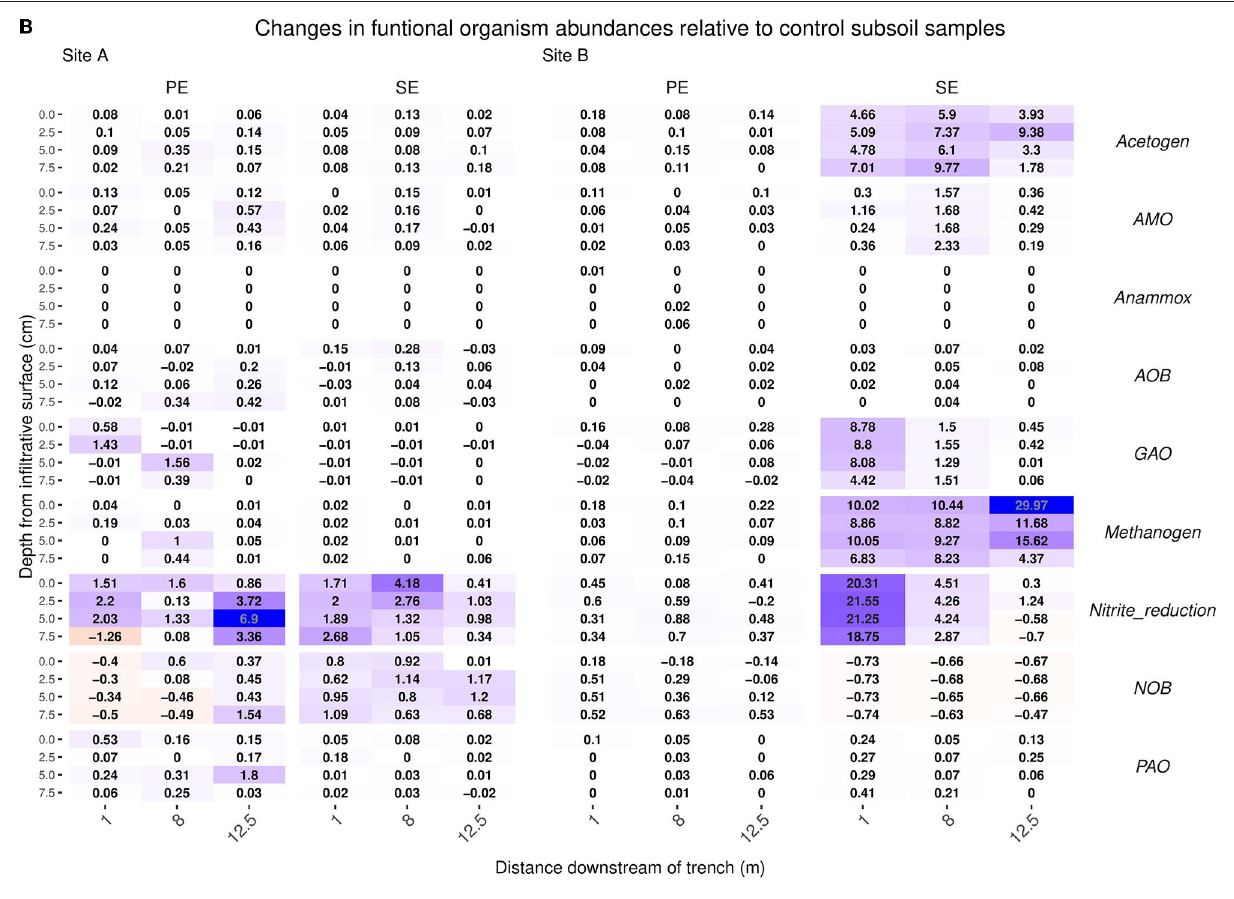
FIGURE 7 | (A) Mean ± SD of relative read abundance of Anaerobic Methane Oxidizers (AMO), Denitrifying bacteria, polyphosphate-accumulating organisms (PAO), Nitrite Oxidizing Bacteria (NOB), Methanogens, Glycogen Accumulating Organisms (GAO), Ammonia Oxidizing Bacteria (AOB), AMO, and Acetogen functional groups for Site A for both the Primary (PE), secondary (SE), and control samples for each “system”: control; base (CB), topsoil (CT), STU topsoil (TT), and STU subsoil “trench base” (TB). The STU base is further divided into proximal (P) at 1m, midpoint (m) at 5m, and distal (d) at 12m. (B) 2D spatial profile of changes of relative abundances of Anaerobic Methane Oxidizers (AMO), Denitrifying bacteria, Polyphosphate-accumulating organisms (PAO), Nitrite Oxidizing Bacteria (NOB), Methanogens, Glycogen Accumulating Organisms (GAO), Ammonia Oxidizing Bacteria (AOB), AMO, and Acetogen functional groups sequences with respect to the control subsoil communities; increases are highlighted in green and reductions in